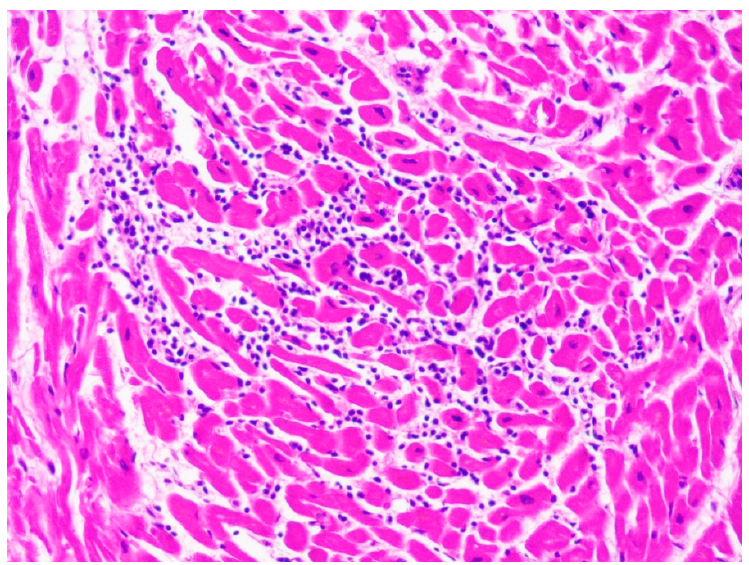
Figure 6. Lymphocytic infiltrate in the case of a 10-year-old child affected by myocarditis (hema- toxylin and eosin stain, 40× magnification).